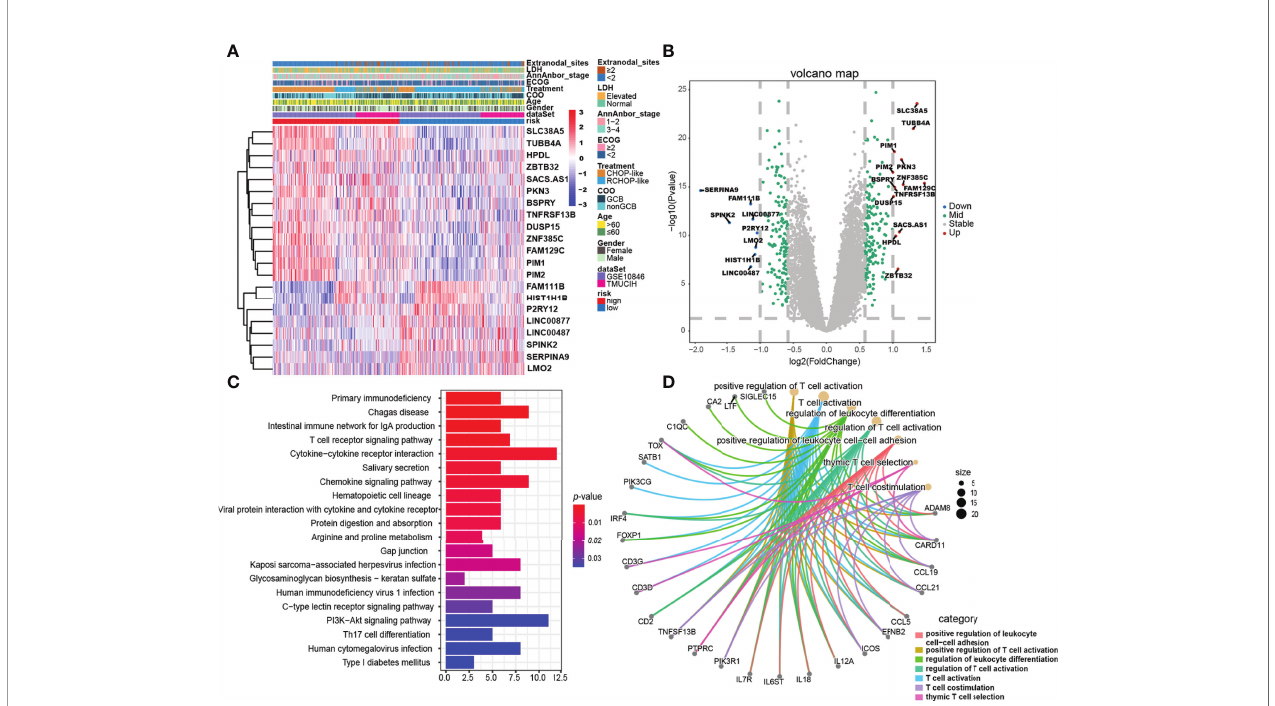
FIGURE 4 | Gene expression differences and relevant biological pathways between the high- and low-risk ELncSig groups. (A) Heatmap of differentially expressed genes between the high- and low-risk ELncSig groups and their clinicopathological characteristics. (B) The volcano plot showing upregulated and downregulated genes between the two groups (|log 2 FC| > 1, adjusted p < 0.05). (C) Heatmap showing the KEGG pathways enriched in the high- and low-risk ELncSig groups. (D) Circle map showing the immune-related pathways regulated by DEGs between the two groups and the genes included in the pathways.